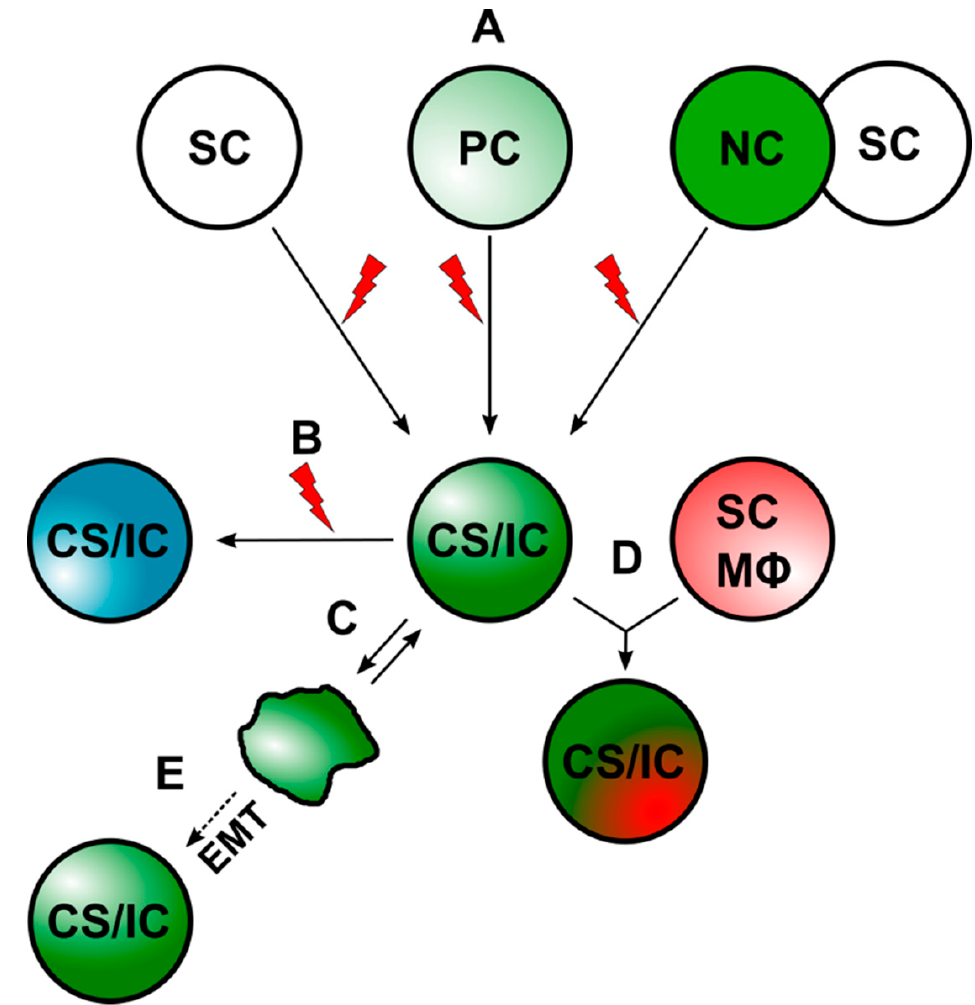
Figure 1. CS/ICs can arise through different mechanisms. ( A ) CS/ICs could originate from normal stem cells (SCs), progenitor cells (PCs), or through cell–cell fusion. The red lightning should indicate mutational events, which drive malignant transformation. ( B ) Mutational events could lead to a new CS/IC subclone. ( C ) Differentiated cancer cells could convert into CS/ICs due to an inherent plasticity. ( D ). CS/ICs could fuse with normal somatic cells (NC), such as stem cells (SC) and macrophages (M φ ). ( E ) Induction of EMT in cancer cells might also give to a CS/IC phenotype.